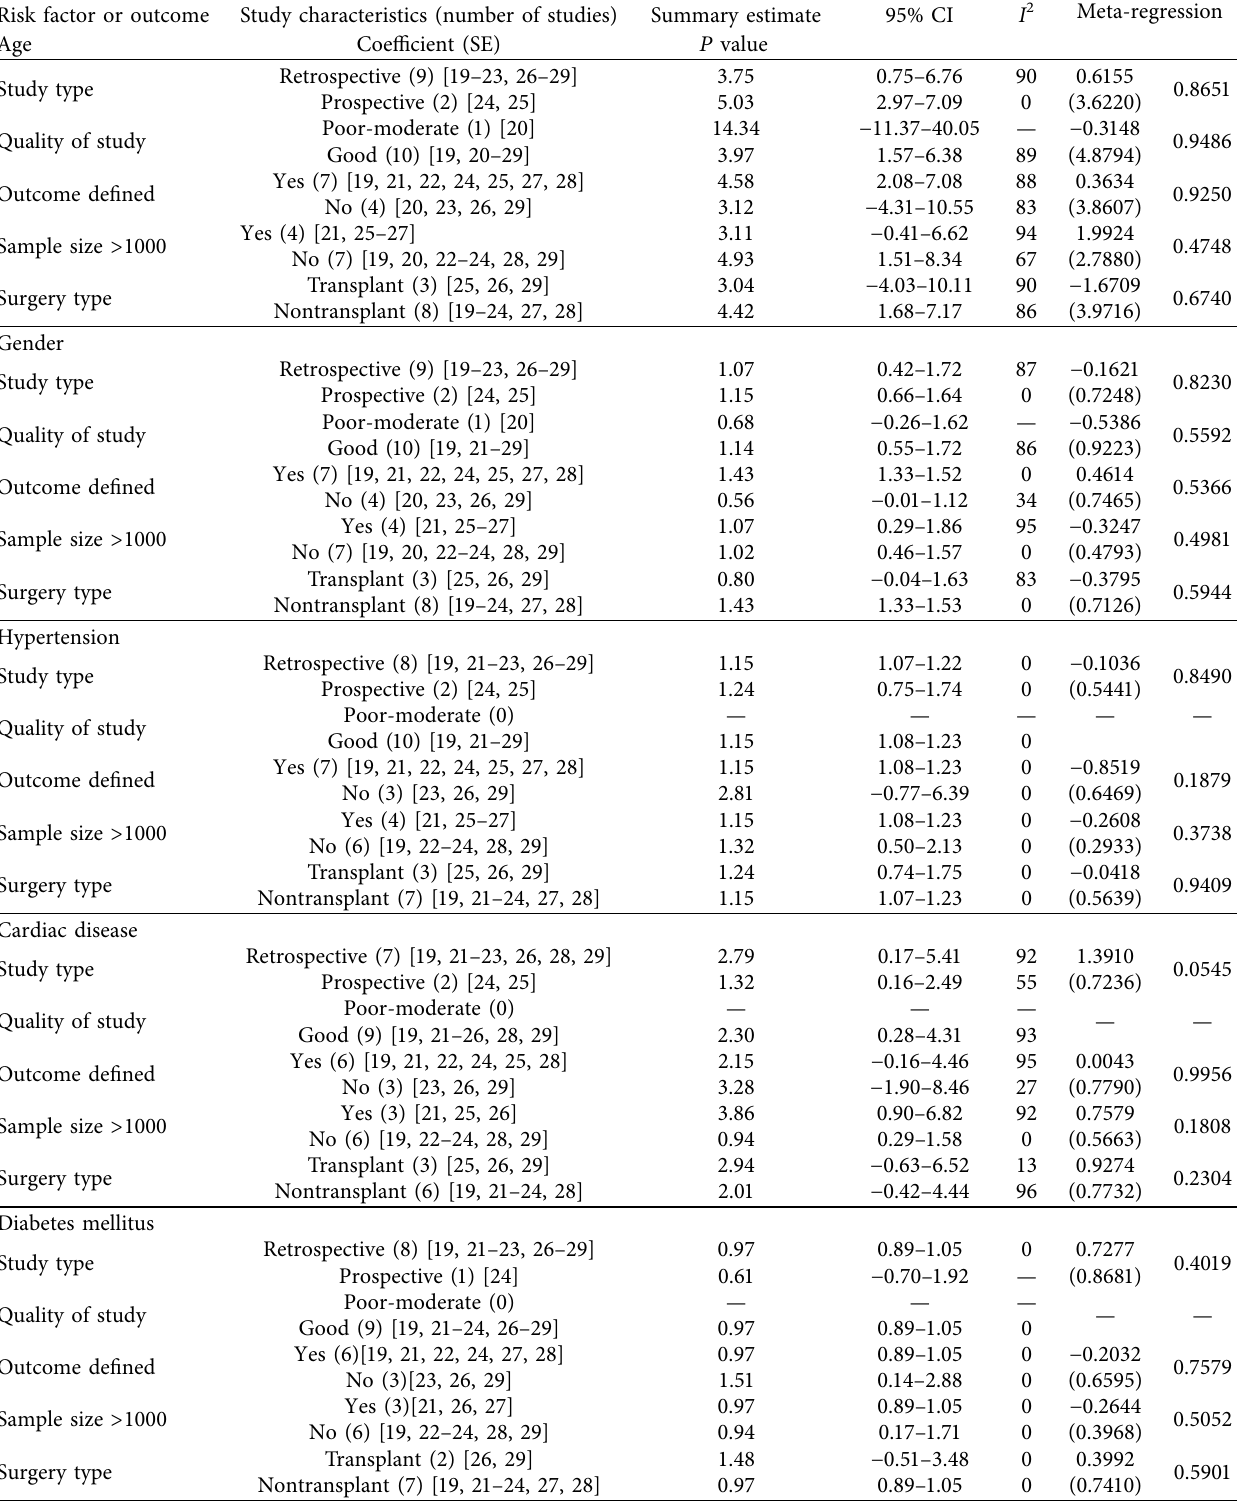
Table 1: Study quality assessment: meta-regression and sensitivity analysis of various subgroups (as categorical